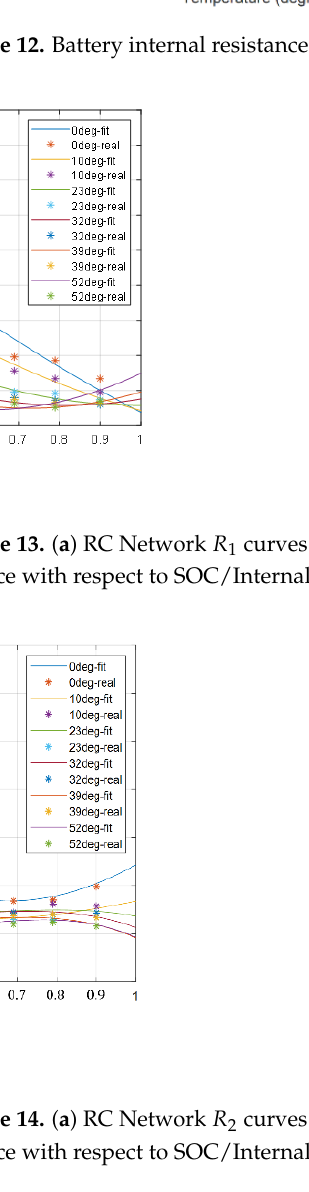
curves with respect to SOC/Internal Temperature; ( b ) RC Network (cid:2870)